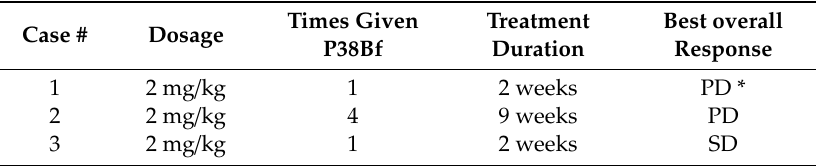
Table 3. Results of dogs treated with